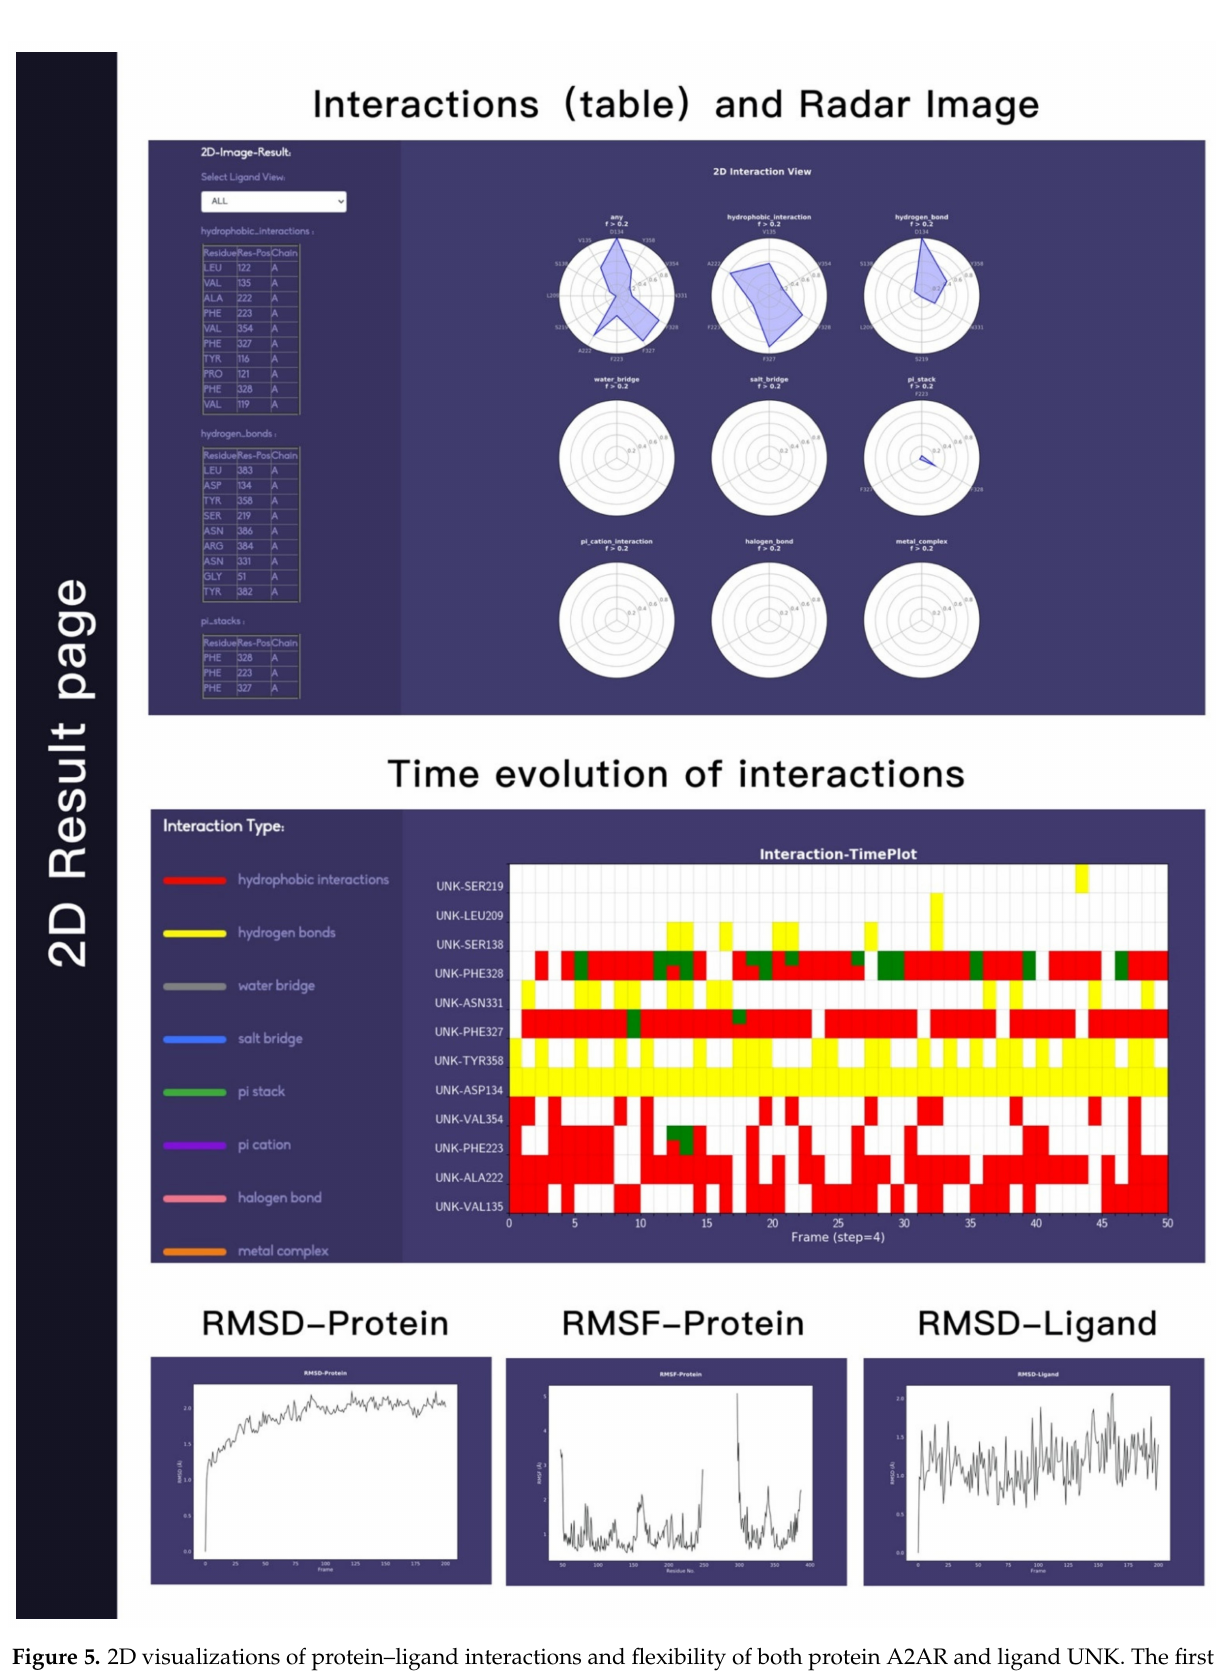
Figure 5. 2D visualizations of protein–ligand interactions and flexibility of both protein A2AR and ligand UNK. The first row mainly displays the interaction in the form of a table and a radar chart. The second row is in the form of a heat map, and the third row is the RMSD and RMSF